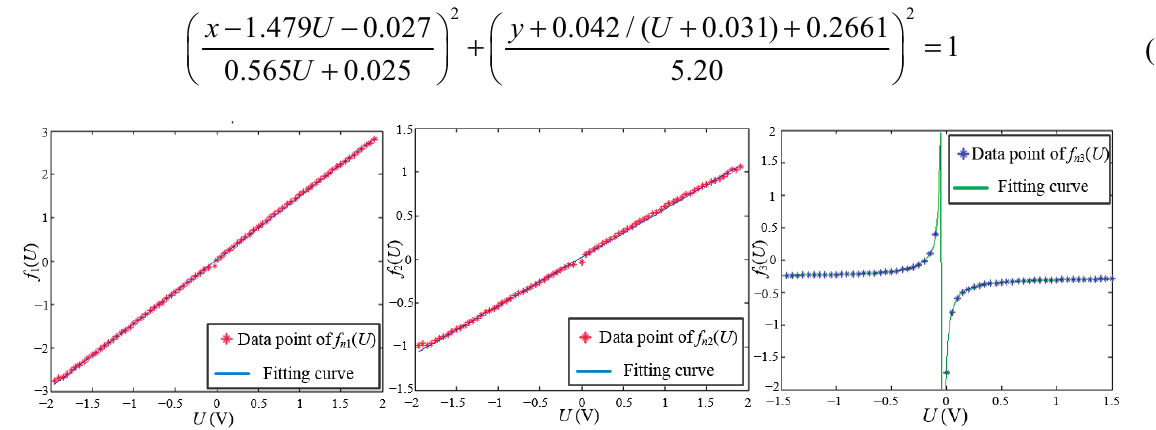
Figure 11. Fitting performance of the parameters f n 1 ( U ), f n 2 ( U ) and f n 3 ( U